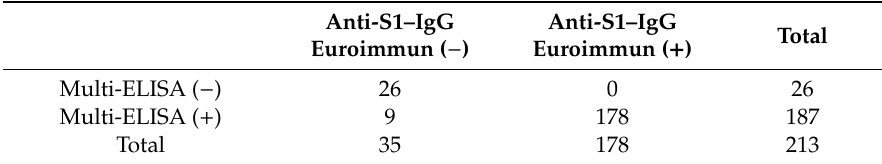
Comparative evaluation of results derived from the Multi-ELISA and anti-S1–IgG Euroimmun